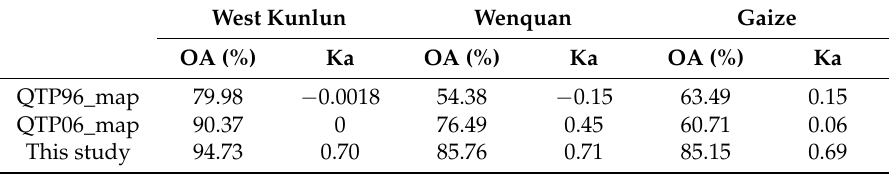
Table 4. Comparison of the accuracy of the frozen soil map of the Qinghai Tibet